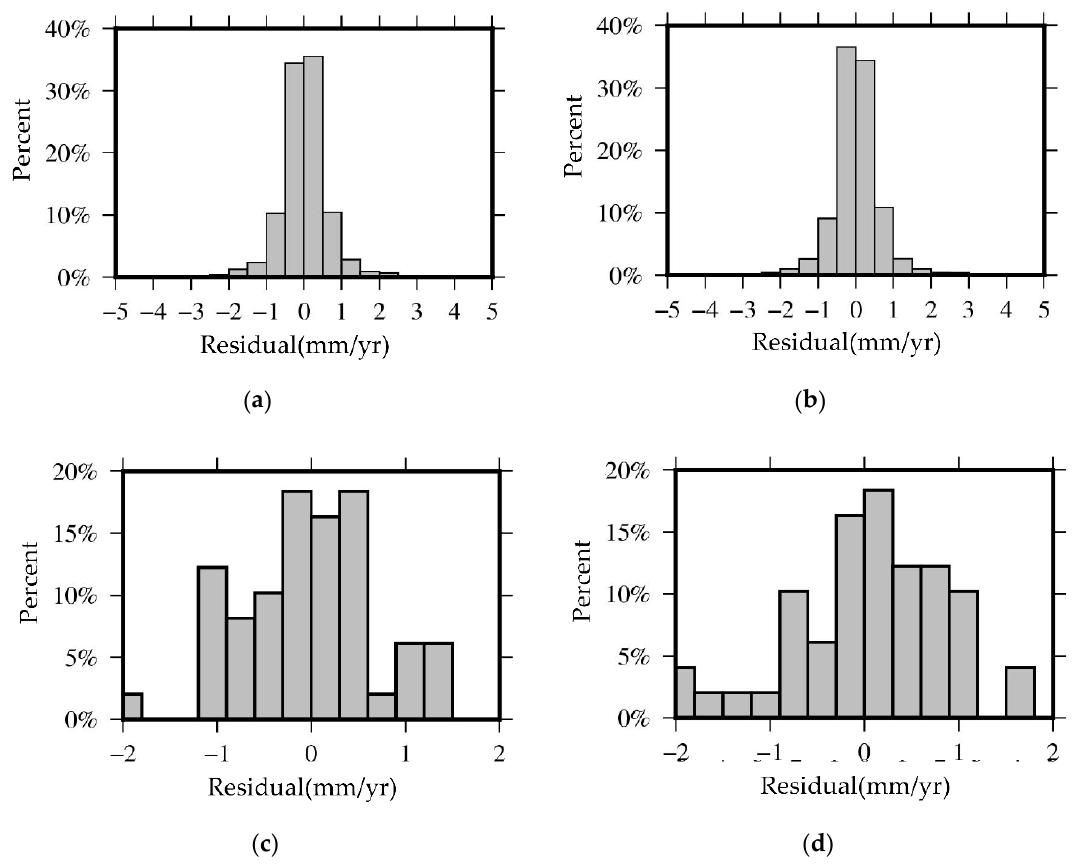
Figure 5. Direct validation and cross-validation of velocity residual results: ( a ) The easterly velocity residual of direct verification; ( b ) The northerly velocity residual of direct verification; ( c ) The easterly velocity residual of cross-verification; ( d ) The easterly velocity residual of cross-verification. Table 3. Direct verification and cross-verification of speed error results.